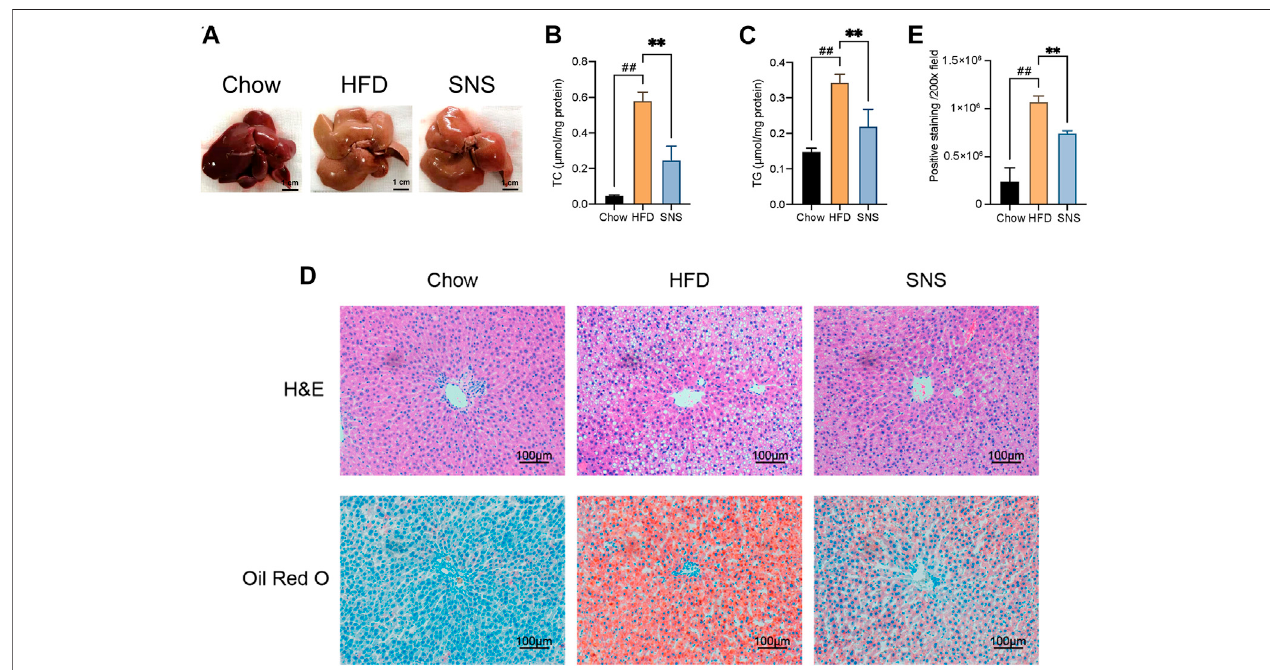
FIGURE 7 | Sinisan reduced liver lipid accumulation. (A) Morphology of the liver in each group. (B) Liver total cholesterol(TC) levels normalized by total protein. (C) Liver total triglyceride (TG) levels normalized by total protein. (D) . HE-stained and Oil Red O-stained liver tissue. (E) Relative evaluation of Oil Red O-staining. Three biological replicates were performed for each study. # p < 0.05, ## p < 0.01, ### p < 0.001 when compared with the Chow group, * p < 0.05, ** p < 0.01, *** p < 0.001 when compared with HFD